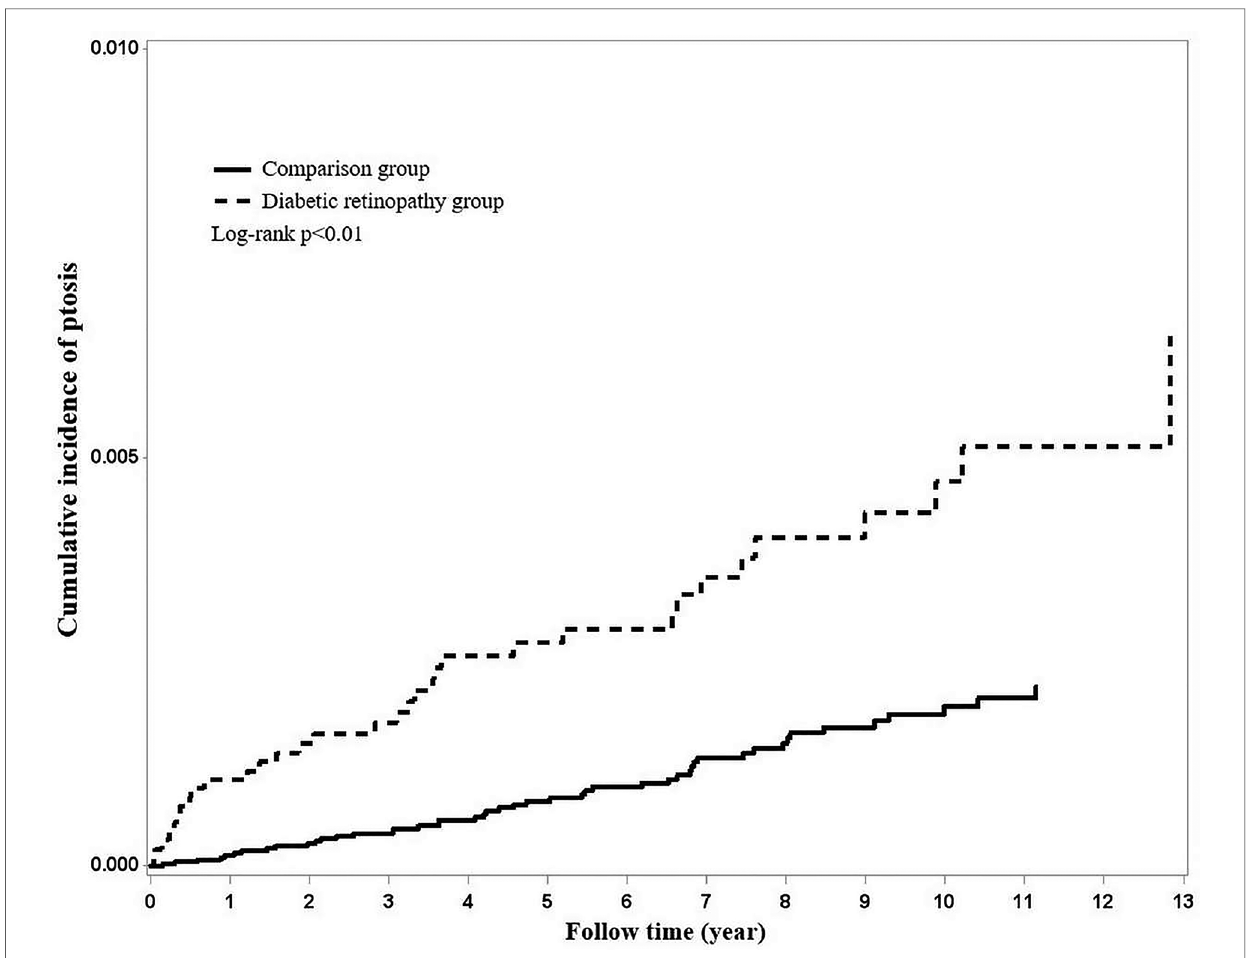
FIGURE 1 Using Kaplan – Meier survival statistics, it showed crude overall survival curves by with and without diabetic retinopathy. (log-rank p